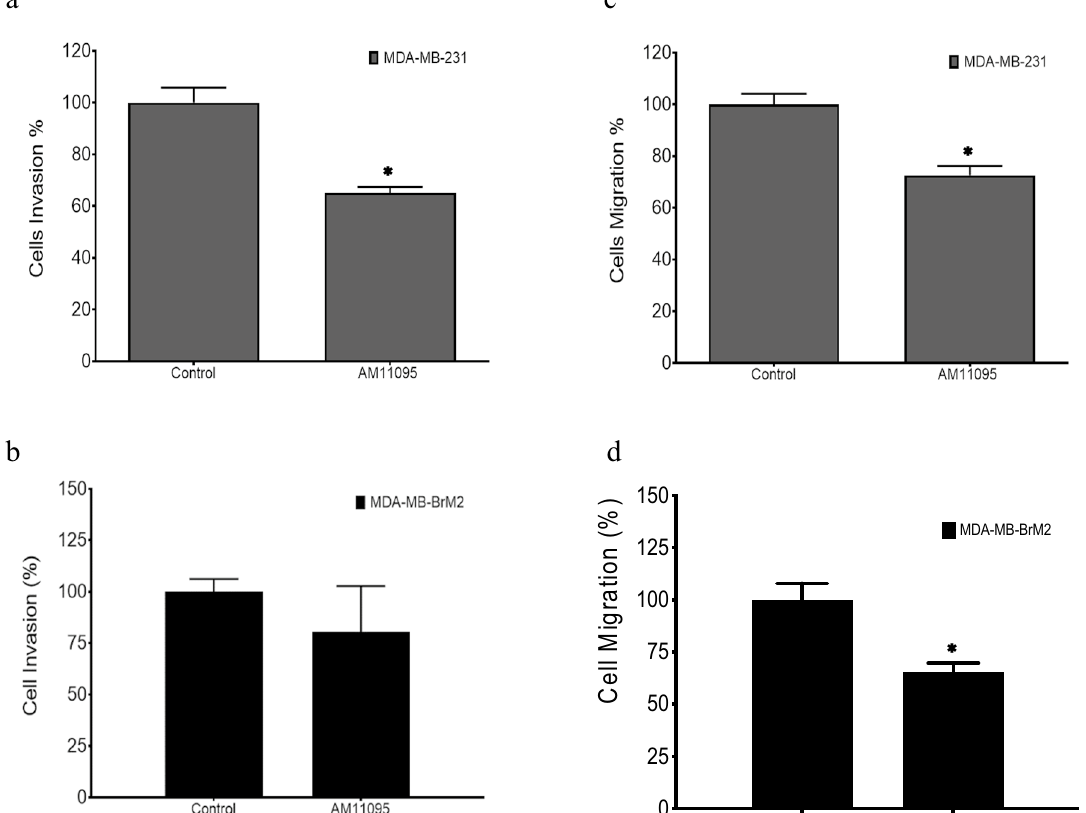
Figure 5. Effects of AM11095 on invasion, and migration of TNBC cells. ( a ), ( b ) Cells were either untreated or treated with either vehicle control or with AM11095 as indicated for 72 h and then assayed for cell invasion. Data shown are representative of at least three independent assays performed on duplicate or triplicate wells. The error bars indicate standard deviations. ( c ), ( d ) Cells were seeded over the monolayer in the presence or absence of AM11095 for 72 h. The resulted fluorescence from Calcein AM cleavage by the migrated cells in bottom plate to free Calcein was measured using a Biotek reader instrument and expressed as the percentage of cells migrated relative to control. Data shown are representative of at least three independent assays performed on duplicate or triplicate wells. The error bars indicate standard deviations. The p-values were calculated by Unpaired Student’s t-Test. (*) P ≤ 0.05, (**) P ≤ 0.01, (***) P ≤ 0.001, (****) P ≤ 0.0001, (n.s) not